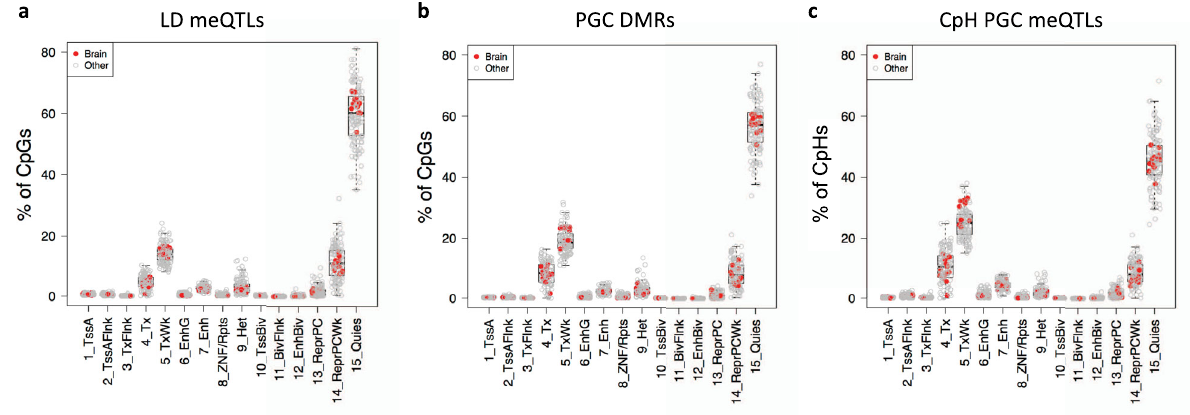
Fig. 2 Chromatin state of meQTLs and gDMRs. We assessed the chromatin state of sites identi fi ed as meQTLs and gDMRs using data from various tissues from the Roadmap Epigenomics Project. Data for brain tissues are highlighted in red. n = 127 tissue types. Chromatin states are de fi ned as follows. 1: Active TSS, 2: Flanking Active TSS, 3: Transcription at gene 5 ′ and 3 ′ , 4: Strong transcription, 5: Weak transcription, 6: Genic enhancers, 7: Enhancers, 8: ZNF genes & repeats, 9: Heterochromatin, 10: Bivalent/Poised TSS, 11: Flanking Bivalent TSS/Enhancer, 12: Bivalent Enhancer, 13: Repressed PolyComb, 14: Weak Repressed PolyComb, 15: Quiescent/Low. a In genome-wide meQTLs, assessing a set of LD-independent SNPs, we see that the vast majority of meQTL-CpGs are in quiescent chromatin regions. b We see that compared to genomic SNPs, CpGs associated with PGC schizophrenia risk SNPs are enriched for regions of active transcription and depleted for regions of quiescent chromatin. c We see that CpH sites associated with PGC schizophrenia risk SNPs are often in regions of active